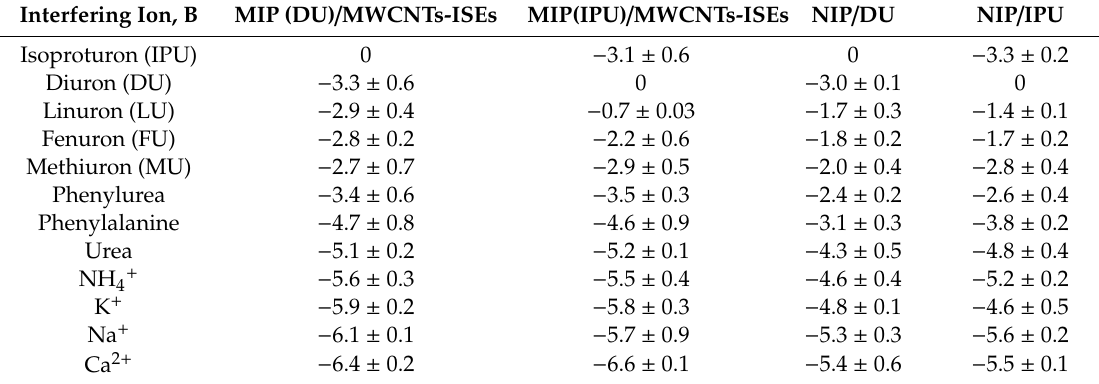
Table 2. Potentiometric selectivity coefficients ( Log K pot i,B ) of phenylureas PVC membrane sensors.